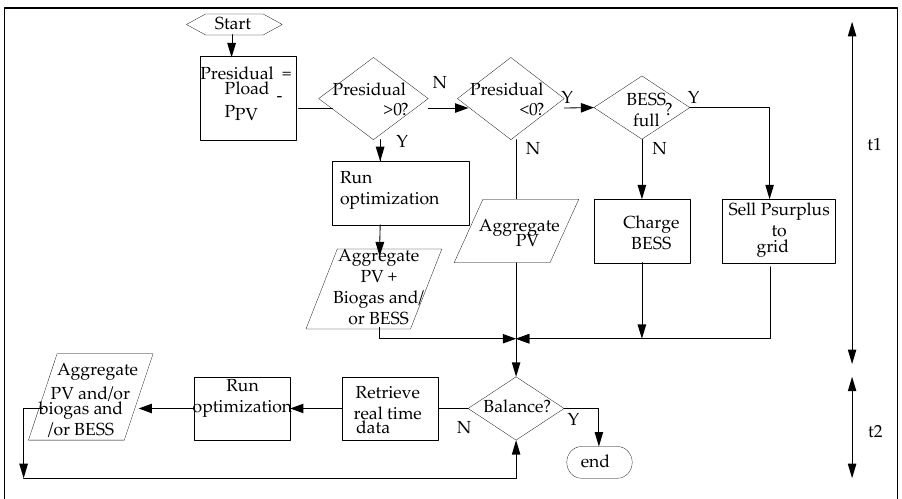
Figure 10. The energy management system (EMS) algorithm of VPP (as in the literature [42]) with a comparator algorithm.